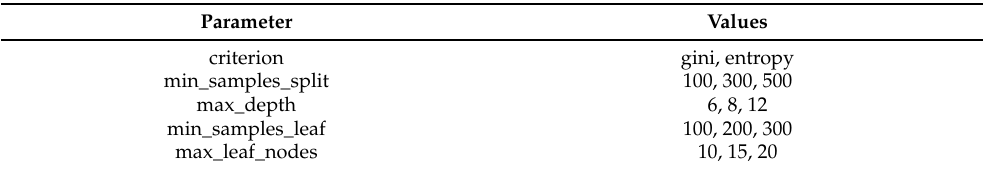
Table A4. Parameters used for the grid search during hyper-parameter tuning for the training of the RF.